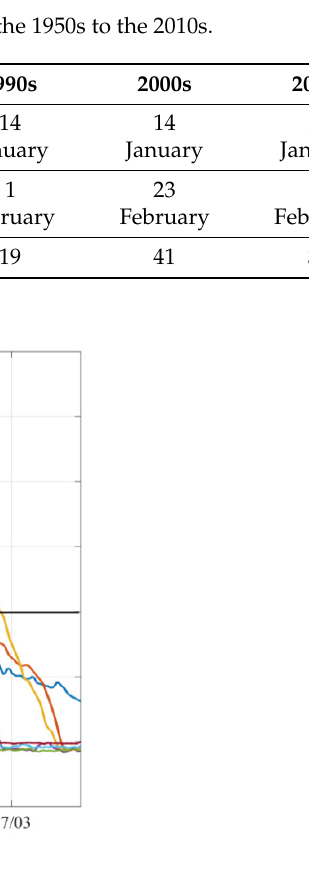
Figure 8. Decadal average seasonal ice-thickness distribution and timing for different ice stages.